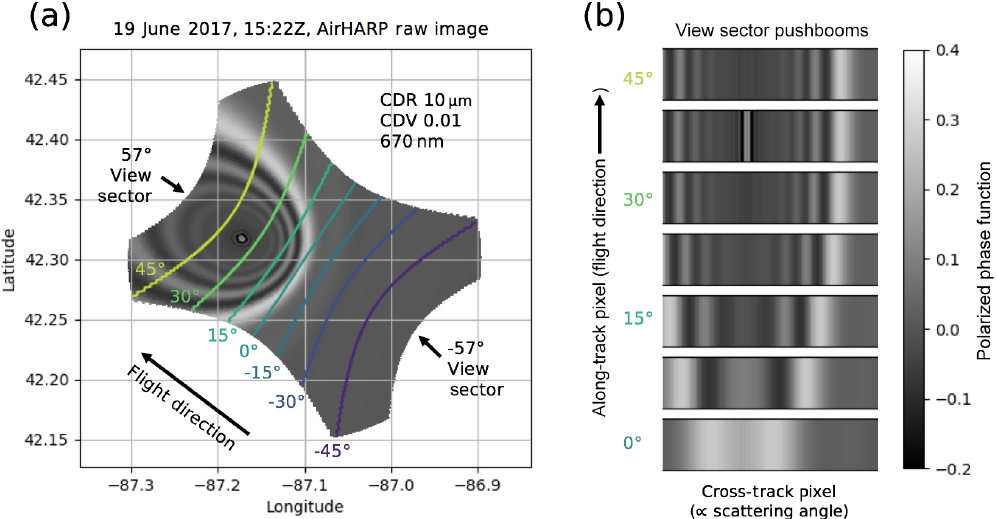
Figure 4. The same simulation as Fig. 3, now with along-track view sector (zenith angle) isolines (a) . A push broom is made when a view sector images consecutive information along-track, shown for seven view sectors, separated by 7.5 ◦ each (b) . Because cross-track pixels represent a cross section of the cloudbow, they are also proxies for scattering angle. Note that the cloudbow distribution is different for each view sector push broom. Since each push broom is projected on a common grid, any pixel or superpixel in common to all of the views can generate a discrete polarized structure. This measurement can be compared to Mie simulations to retrieve CDR and CDV at the target